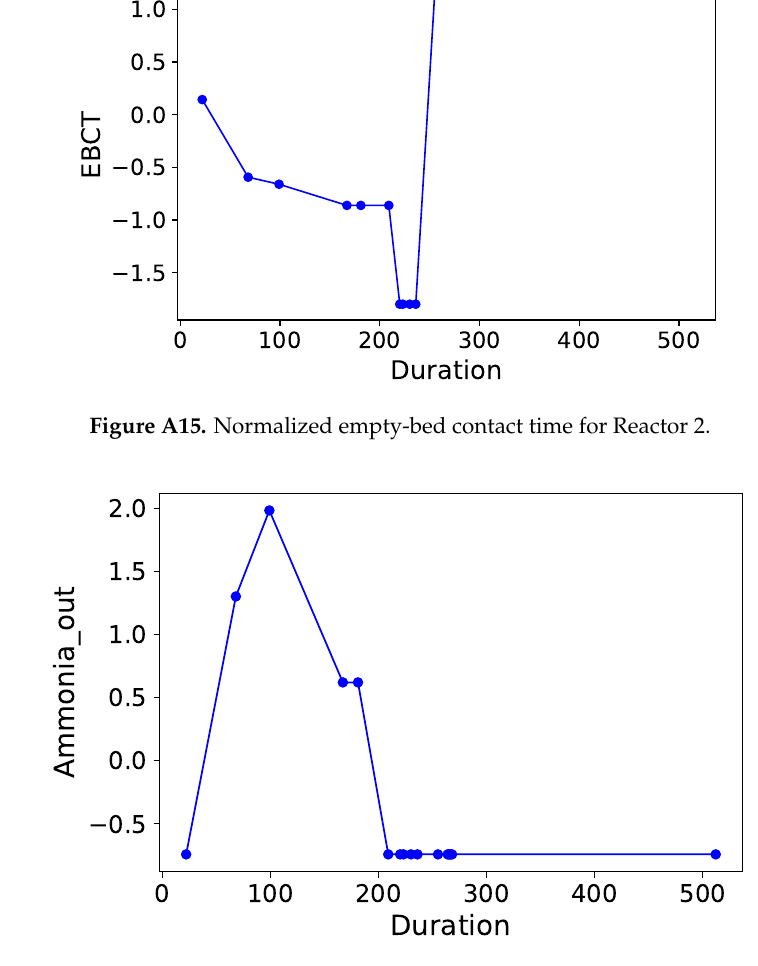
Figure A16. Normalized ammonia outlet flowrate for Reactor 2.